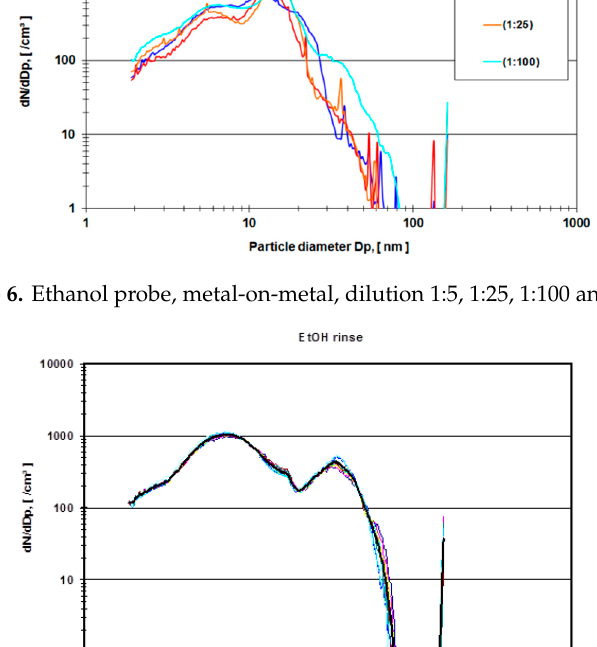
Figure 7. Ethanol rinse, pure ethanol, no dilution.